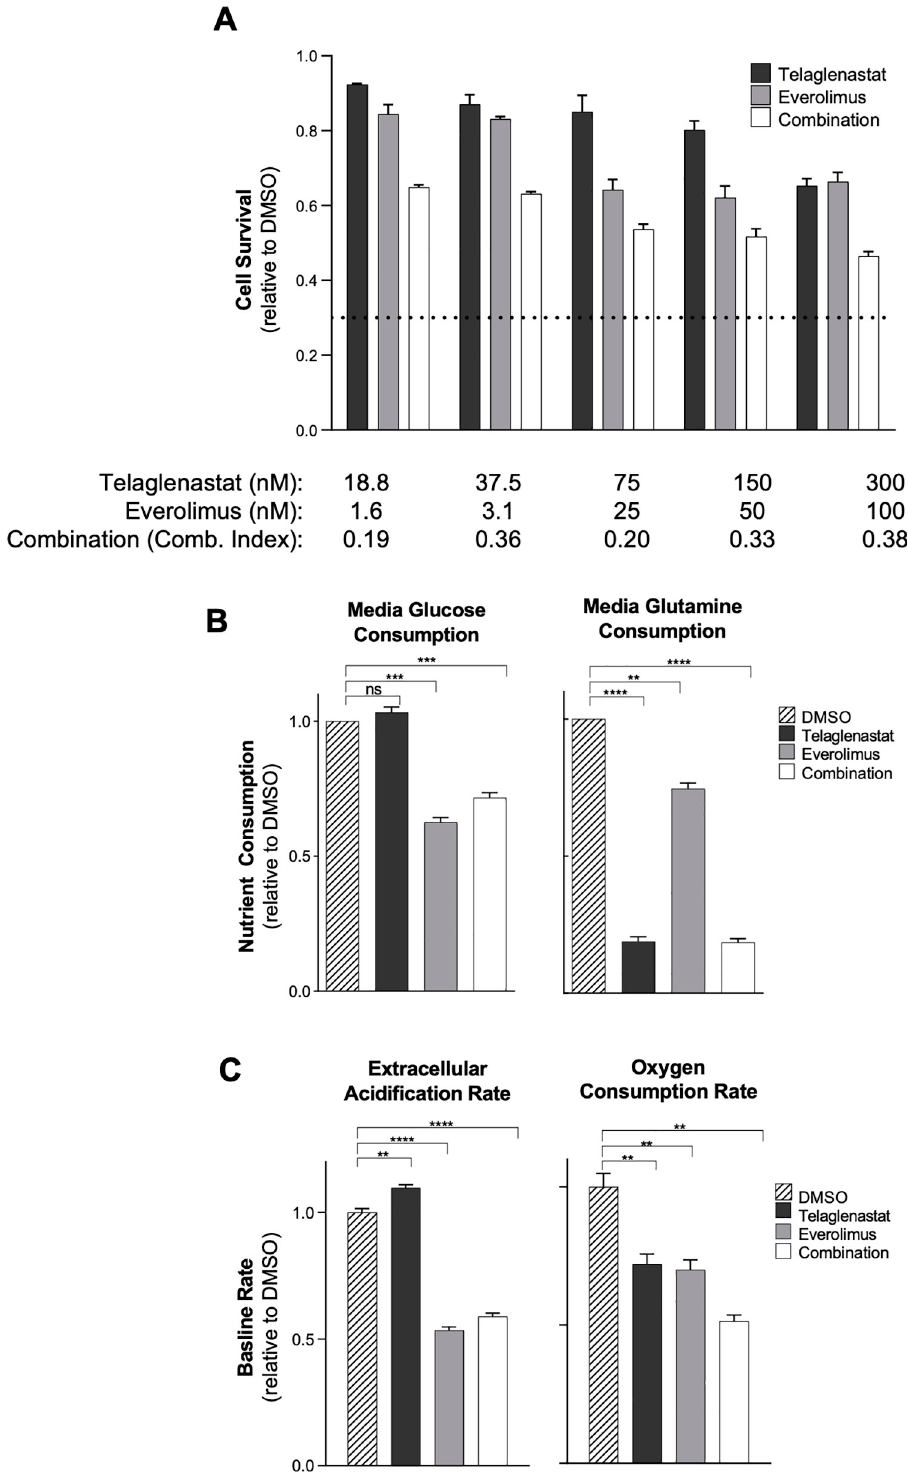
Fig 3. Synergistic anti-proliferative activity and disruption of glutamine and glucose metabolism by telaglenastat and everolimus in RCC cells. (A) Viability of ACHN cells treated with telaglenastat, everolimus, or a combination of both inhibitors for 72 hours. Dotted line indicates the baseline CellTiter-Glo signal at the time of compound addition. (B) Measurements of glucose or glutamine consumption from media of ACHN cells treated with 75 nM